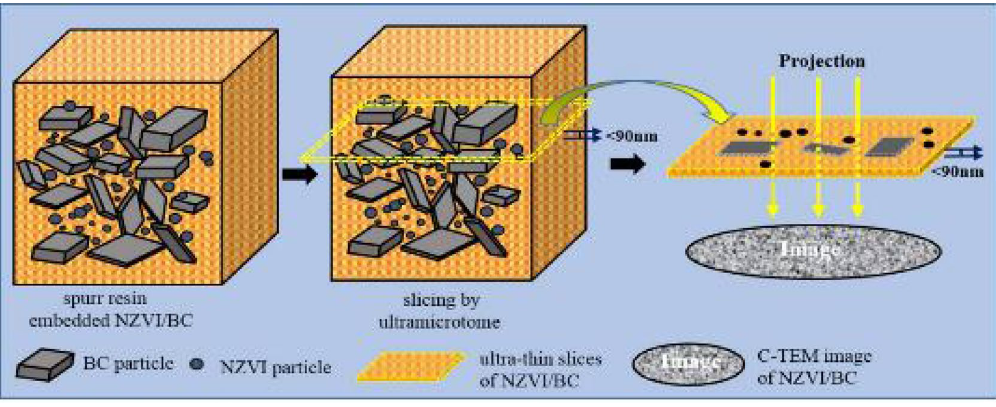
Figure 8. Schematic of ultra-thin slice of NZVI/BC